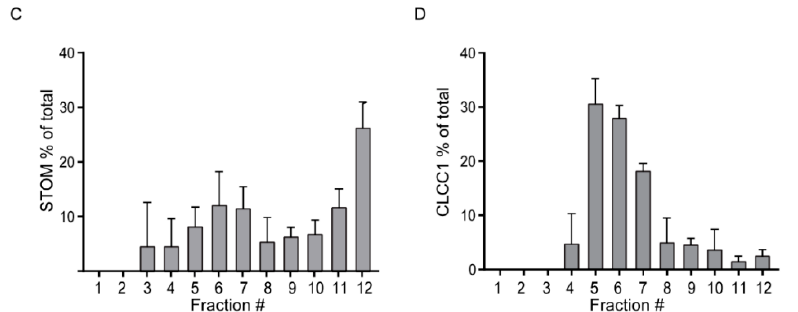
Figure 3. NTCP, stomatin and CLCC1 are localized in the same detergent resistant membrane (DRM) compartment. ( A ) Detection of proteins in fractions (number indicated at the top) obtained after Lubrol treatment and sucrose gradient separation in U2OS cells expressing HA-hNTCP. Western blot is representative of at least two independent experiments. ( B ) Distribution of NTCP, ( C ) stomatin (STOM) and ( D ) CLCC1 in fractions of U2OS cells expressing HA-hNTCP. Graphs display mean +/ − SD.